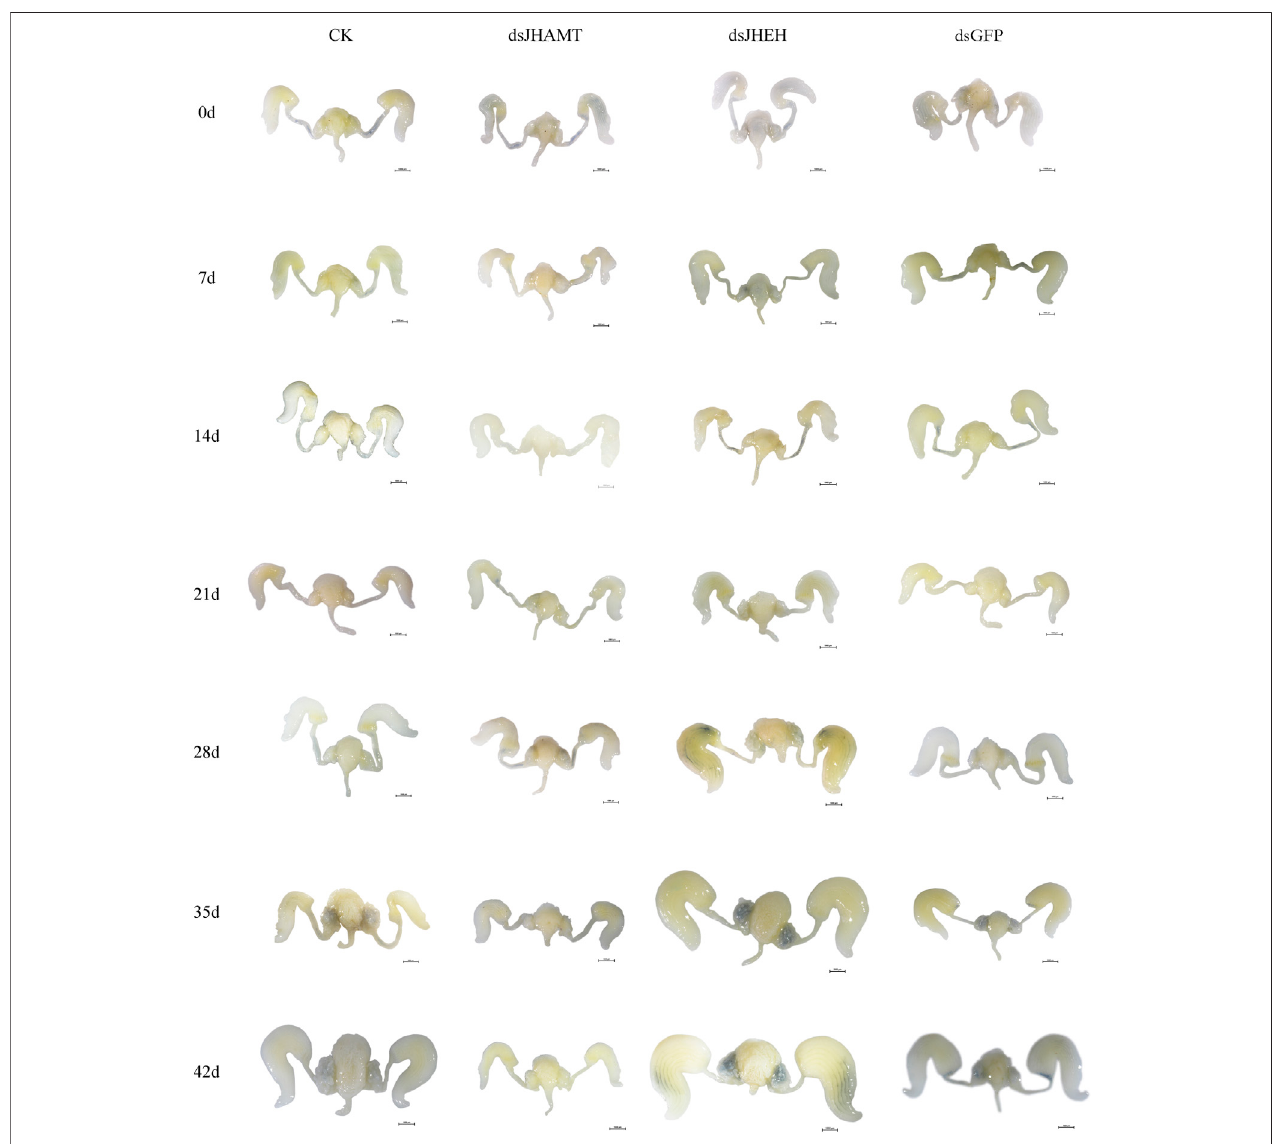
FIGURE 7 | Development pattern of female reproductive system after A. chinensis injected with